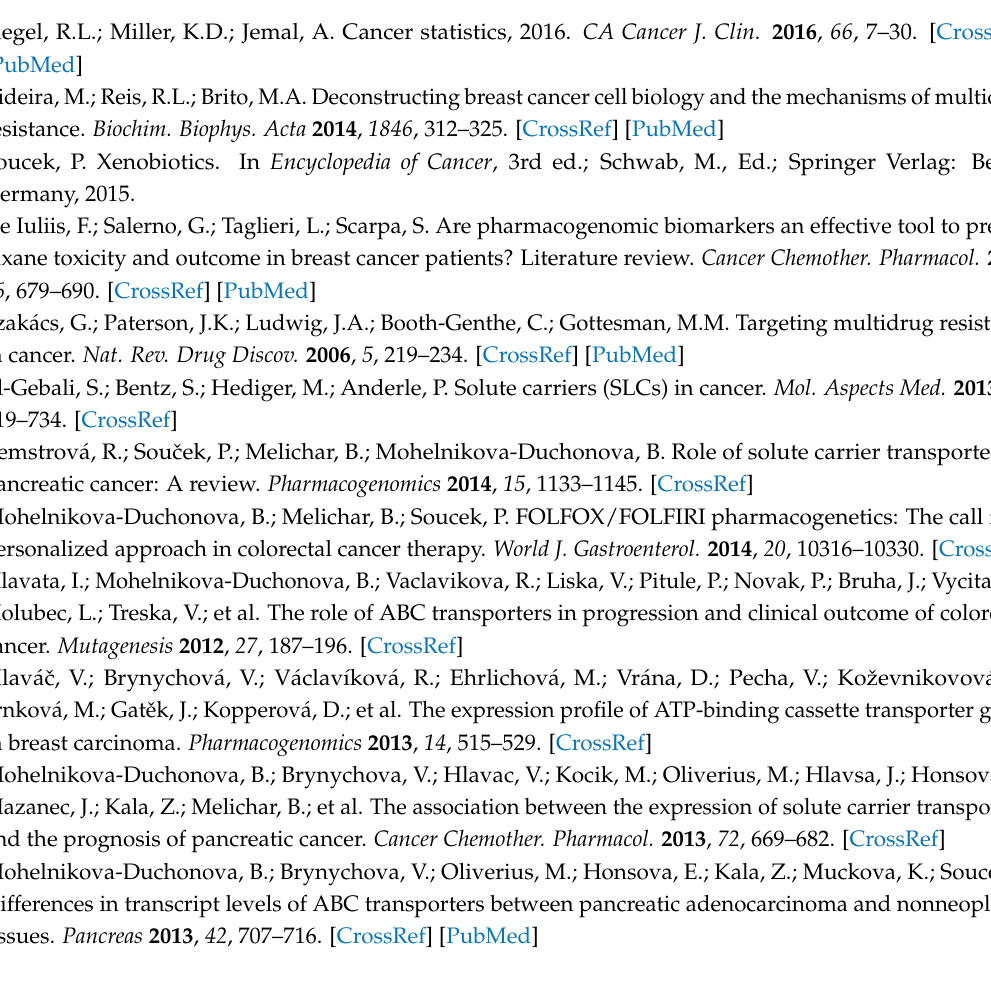
s1, Figure S1: Groups of genes selected for the study, Figure S2: Detailed distribution of alterations in the studied groups of genes, Figure S3: Data curation from PharmGKB data files, Figure S4: Kaplan-Meier plots representing associations of variants with DFS of whole set of patients (rs12460651 and rs751141) or patients treated with hormonal without cytotoxic therapy (rs2075061), Table S1: Treatment regimens in the testing set of patients, Table S2: List of genes selected for the study, Table S3: List of associations between individual variants and survival or response of patients to cytotoxic therapy, Table S4: In silico predictions for variant prioritization. Table S5: Treatment regimens in the validation set of